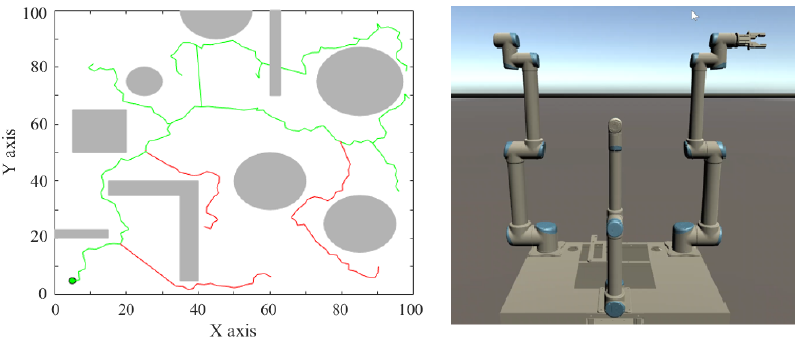
Figure 14. Trunks of the tree and the simulation environment. (( left ) The trunk of a rapidly exploring random tree and the red branches will be removed, ( right ) simulation environment for robot